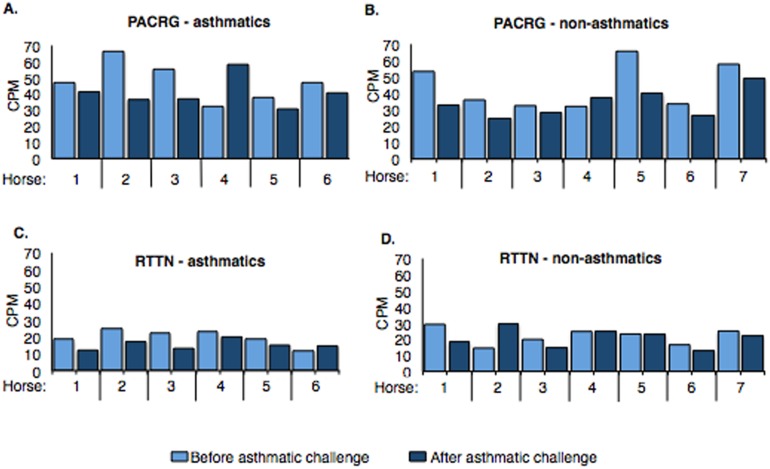
Expression of PACRG (A, B) and RTTN (C, D) in asthmatic and non-asthmatic horses in counts-per-million (CPM; y-axis) pre- and post-challenge.PACRG expression varied from ∼30.7 to 66.3 CPM in asthmatic horses (A) and ∼25.1 to 65.6 CPM on non-asthmatic horses (B), while RTTN expression varied from ∼11.5 to 24.9 CPM and ∼13.1 to 29.9 CPM in asthmatic (C) and non-asthmatic (D) horses, respectively.